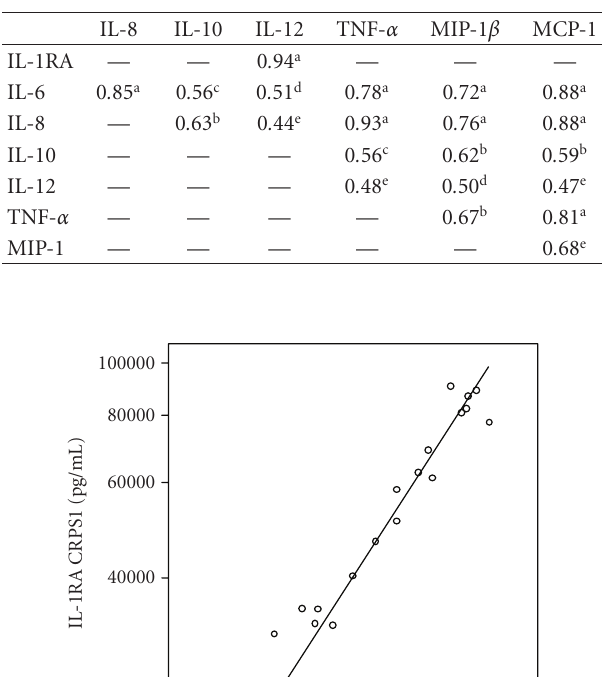
Table 4: Nonparametric correlations of cytokines in blister fluid from CRPS1 hand. P -values: a < . 001, b < . 005, c < . 01, d < . 02, e